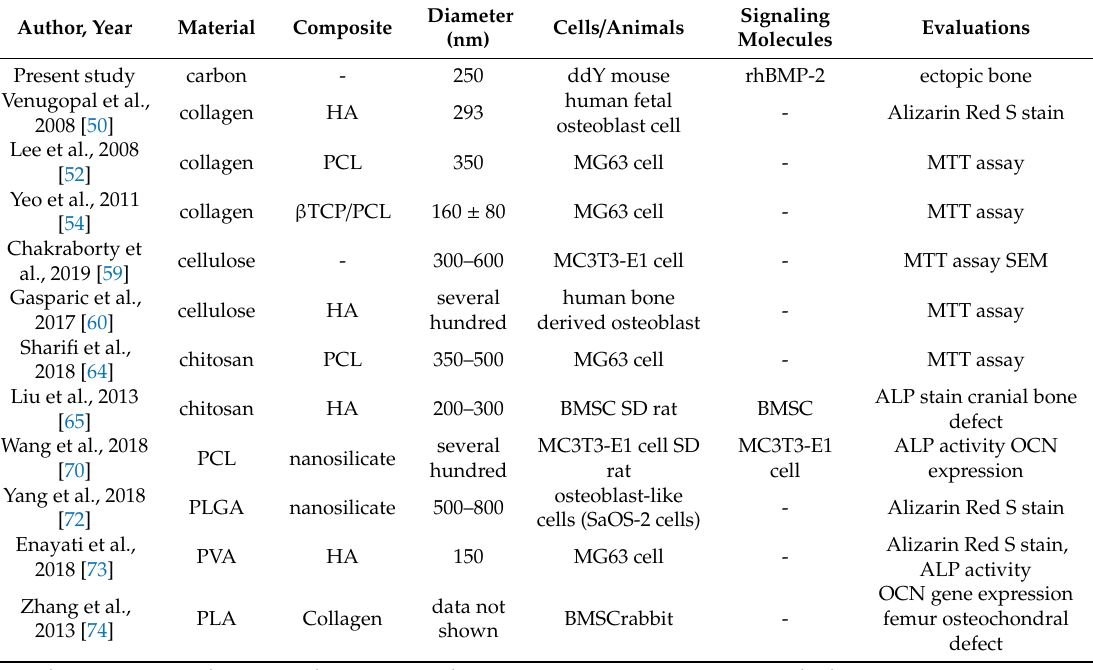
Table 2. The literature on electrospun nanofiber-based sca ff